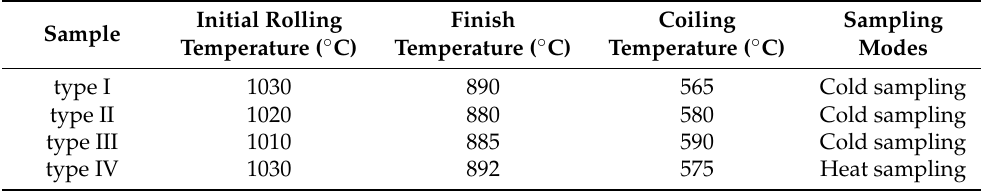
Table 2. Hot roll steel strip processing